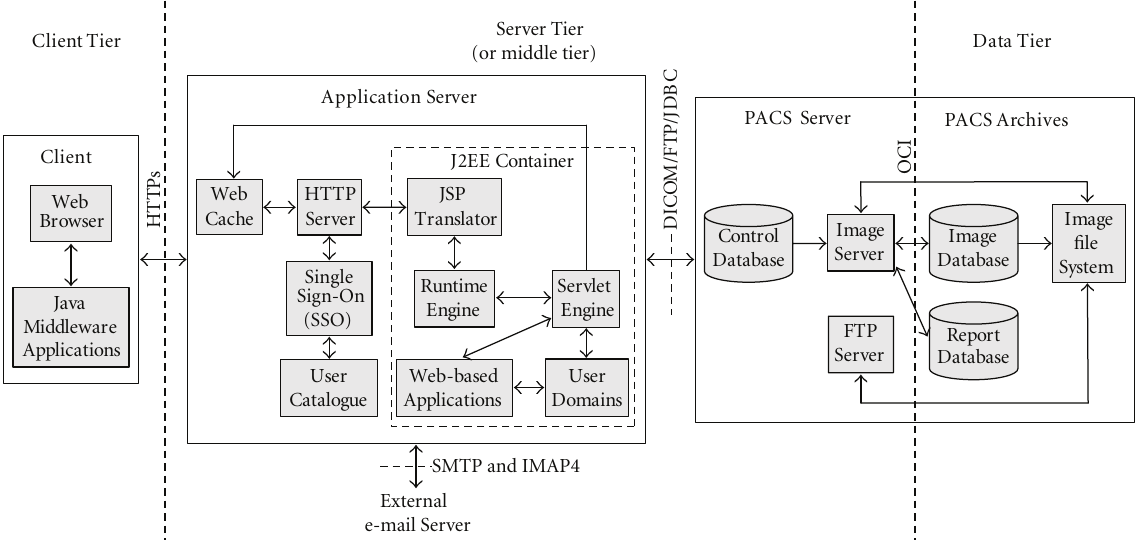
Figure 3: The operational components in the implementation of the teleradiology platform architecture.